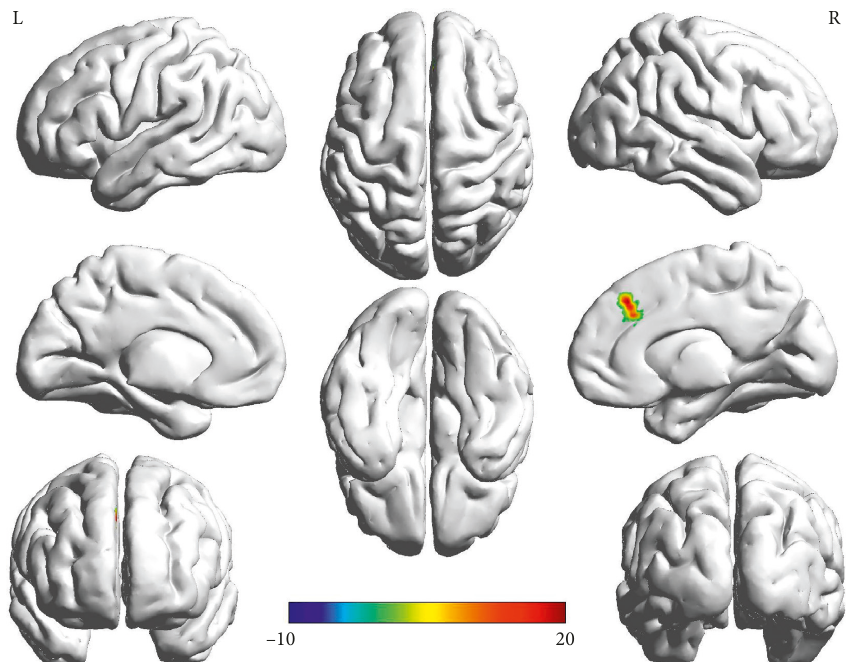
Figure 2: The interaction between groups and genotypes found in the right medial frontal gyrus. The finding was obtained via two-way factorial analysis of covariance (ANCOVA: groups genotypes; groups: PD and HC, genotypes: Ser/Ser carriers and the Gly carriers) × adjusting for age, gender, and education. A corrected threshold by Monte Carlo simulation was set at P 0 . 001. The color bar indicates the F values from ANCOVA. Abbreviations: PD, Parkinson’s disease; HC, healthy control; ALFF, amplitude of low-frequency fluctuations; DRD3, dopamine receptor D3 gene; R, right; L, <